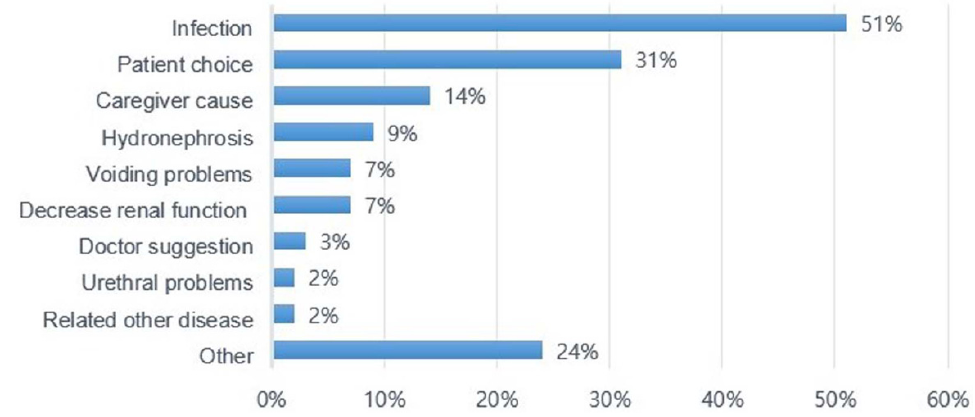
Figure 3. The reasons for changing bladder management ( n =